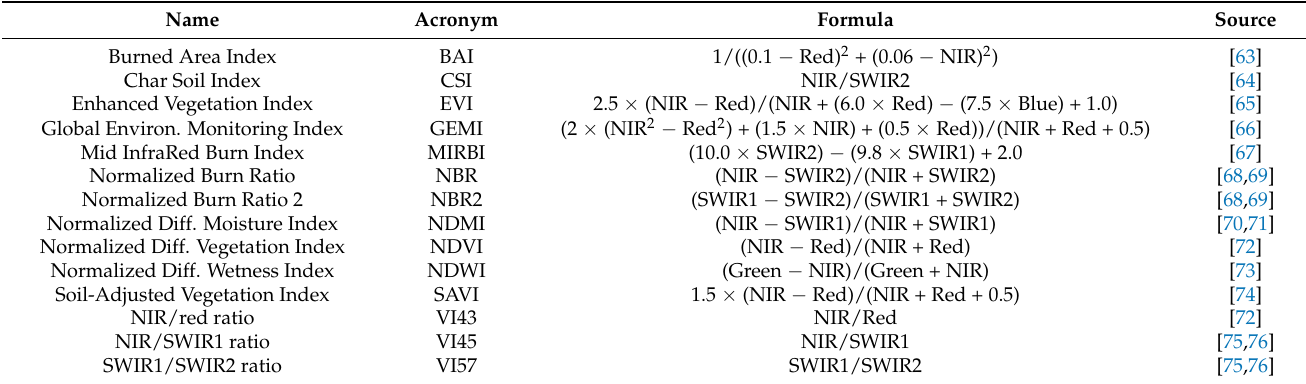
Table 1. Spectral indices included as potential predictors to identify burned area. NIR = near infrared, SWIR = shortwave infrared. Environ. = Environmental, Diff. =